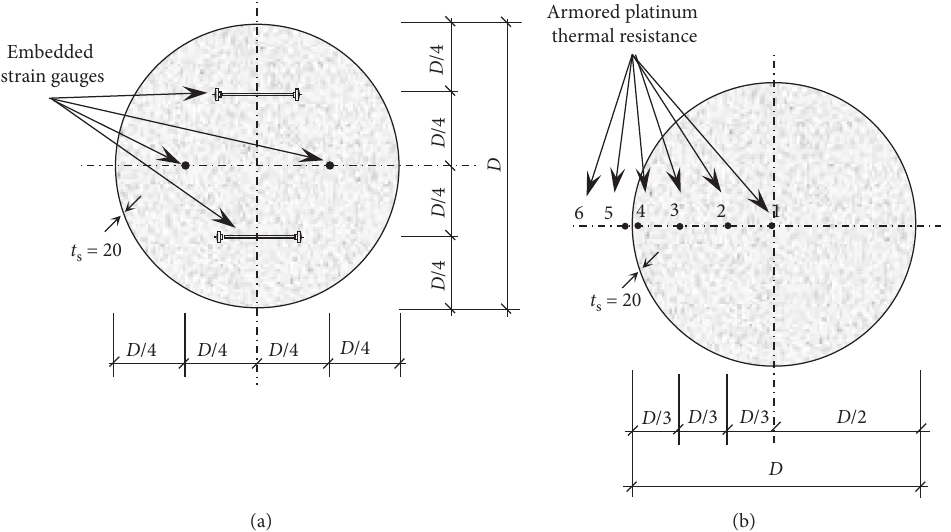
Figure 3: Arrangement drawings of test instruments for cross section of column (unit: mm). (a) Layout of deformation measurement points. (b) Layout of temperature measurement